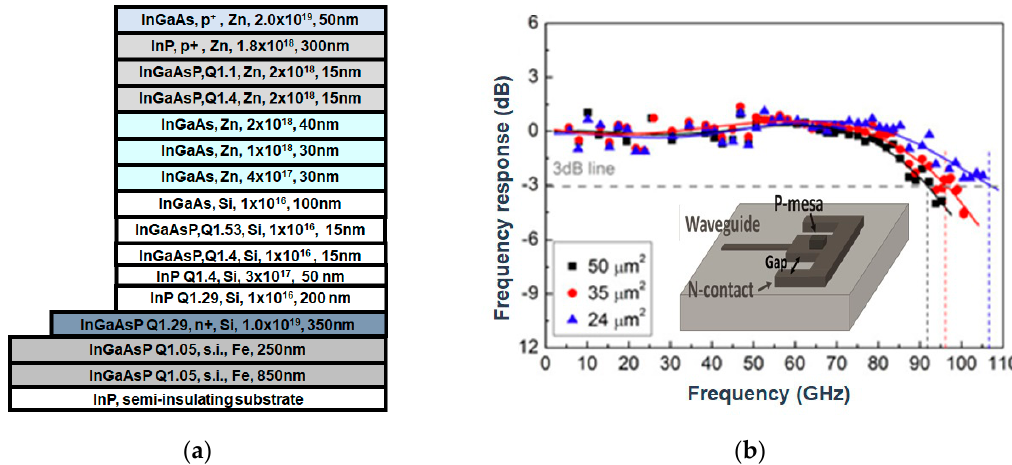
Figure 2. ( a ) Layer stack of waveguide MUTC PD; doping concentrations are given in cm − 3 ( b ) Frequency responses of PDs with different active areas; inset: schematic layout.